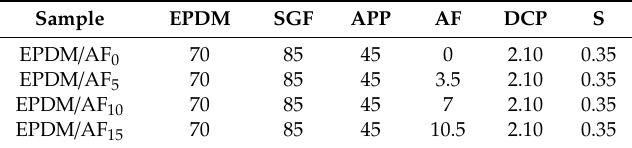
Table 1. Formulations of ceramifiable EPDM composites